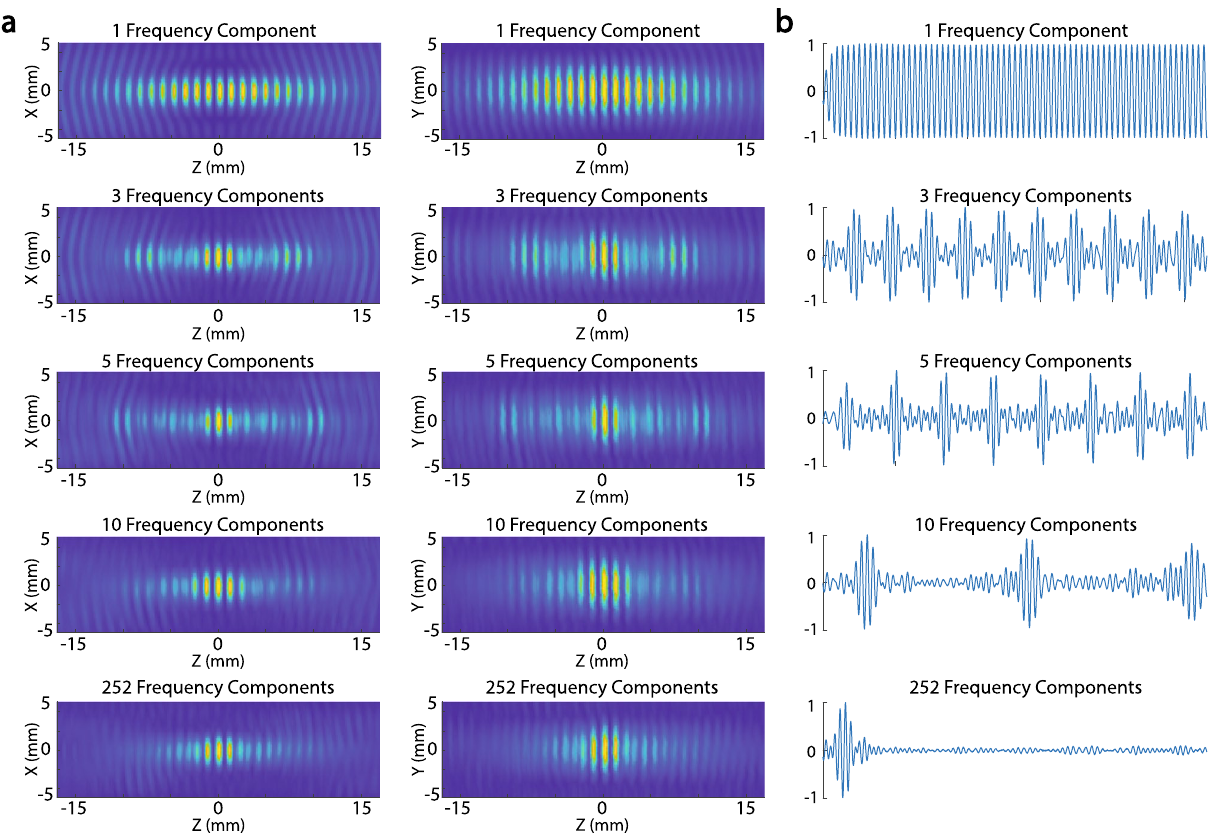
Figure 5. Fields and waveforms at target for all measured frequency combinations. ( a ) Same hardware and approach as in Fig. 2b, but now separately (rows) for 1, 3, 5, 10, and 252 frequency components (equally spaced between 500 and 800 kHz) and separately for the X (left column) and Y (middle column) components of the fields. ( b ) The waveforms at target that result from the superposition of the particular number of